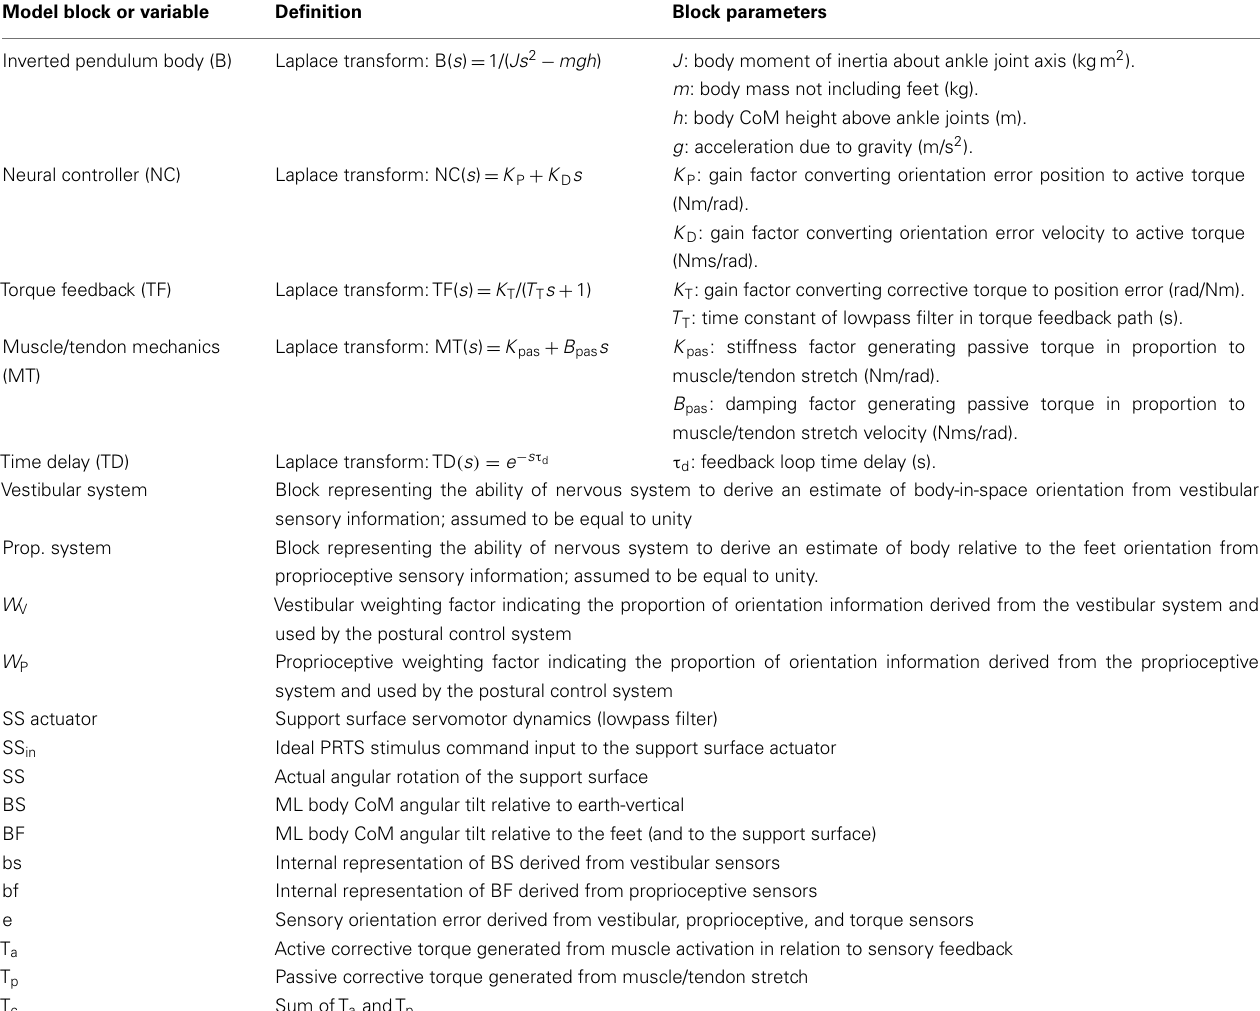
Table 2 | Posture model parameters and definition of